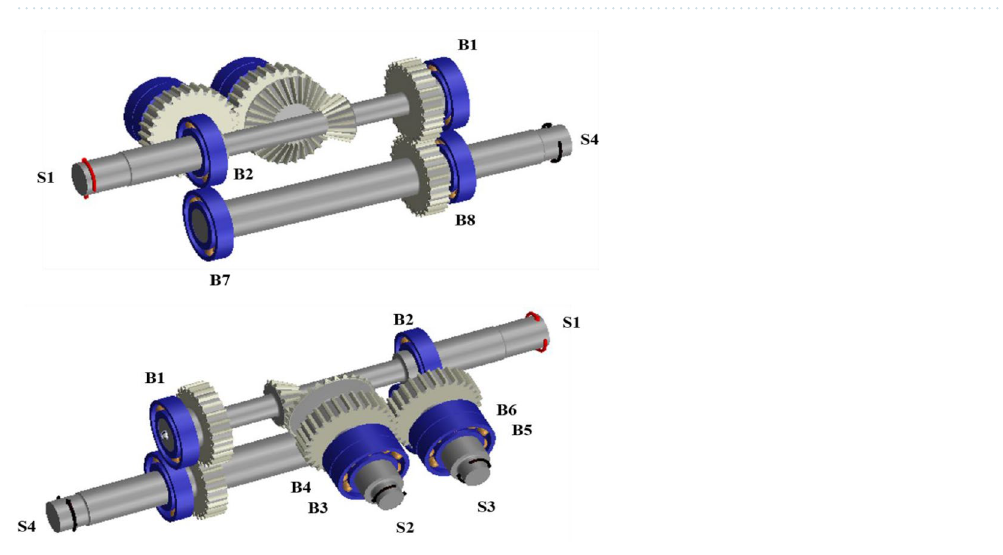
Figure 3. Gearbox simulation model of maize